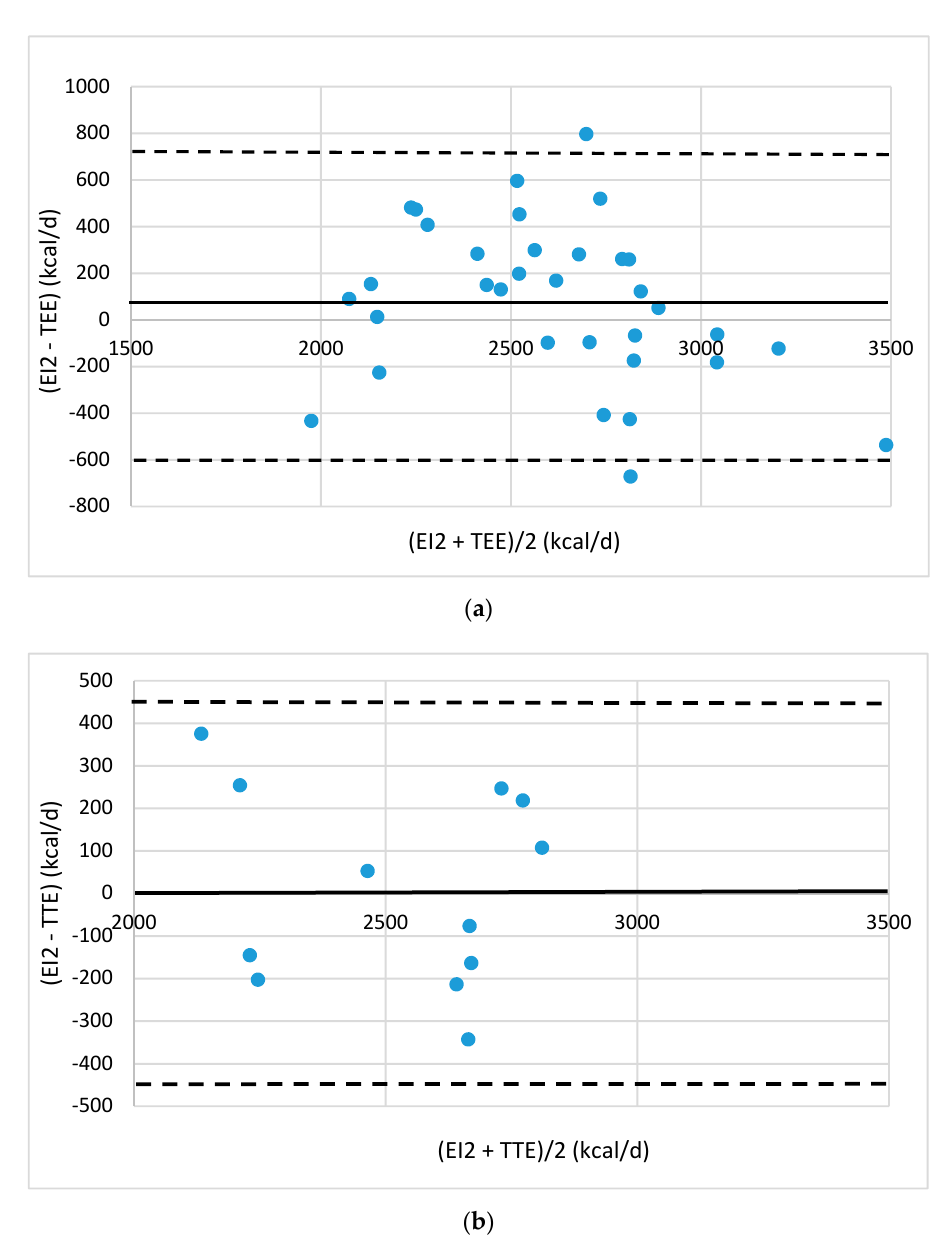
Figure 2. Bland – Altman plots of the agreement level between total energy expenditure (TEE) meas- Figure 2. Bland–Altman plots of the agreement level between total energy expenditure (TEE) measured by eMouve, and ured by eMouve, and energy intake (EI 2 ) estimated by NutriQuantic in normal-weight men ( a ) in energy intake (EI 2 ) estimated by NutriQuantic in normal-weight men ( a ) in the training group and ( b ) in the test group. the training group and ( b ) in the test group. Bias is represented as mean difference (two standard Bias is represented as mean difference (two standard deviations).